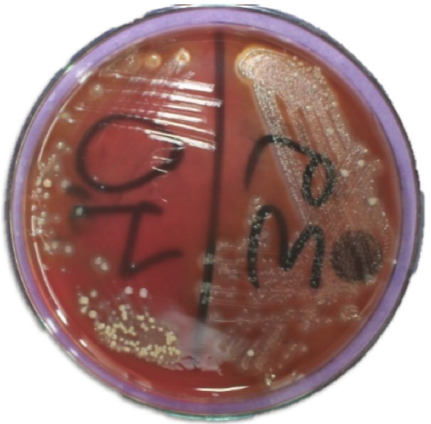
Figure 1: Occlusal tubercle in the mandibular premolars.